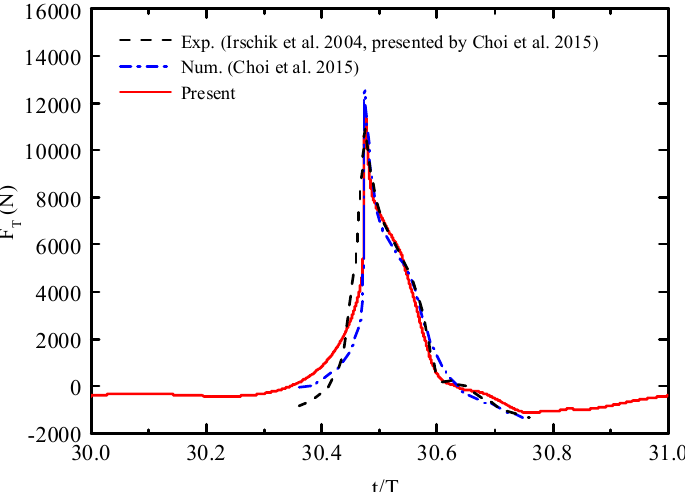
Figure 8. Comparison of breaking wave forces between the present result and the published data for the inclined cylinder ( ϕ = − 22.5 ◦ ).